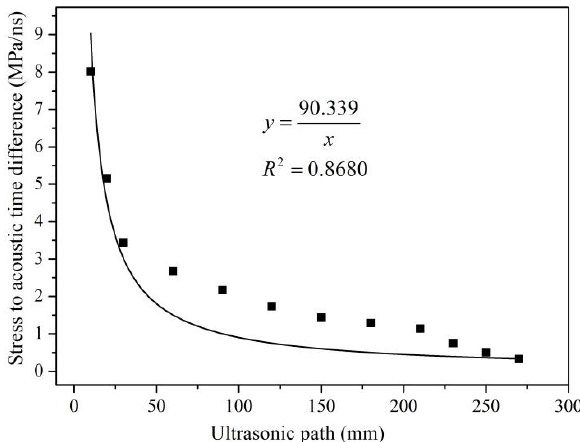
Figure 10. Fitting trend line between probe distance and the SATD factor of steel plate D.